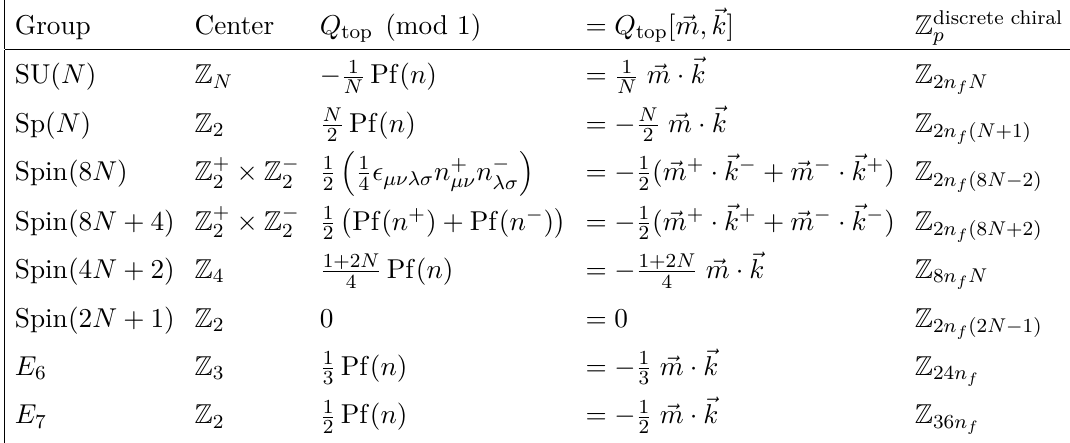
Table 1 . Summary of the topological charges mod1 on T 4 for all gauge groups with non-trivial center. There are two twists, n ± , in Spin(4 N ) . The last column shows the discrete chiral symmetry µν in the theory with n f massless adjoint Weyl